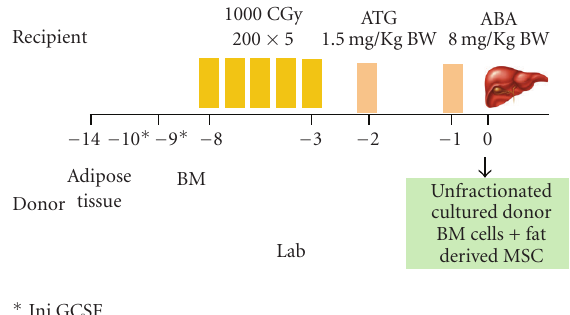
Figure 1: Ahmedabad paradigm of Cotransplantation of insulin secreting and hematopoietic stem cells for